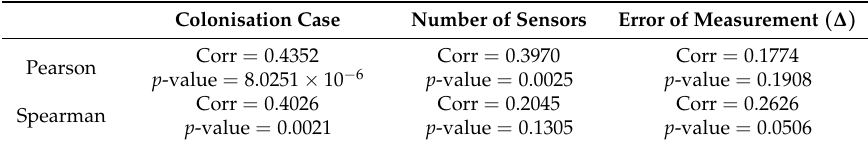
Table 12. Correlation between metrics for b and inputs of scenarii.